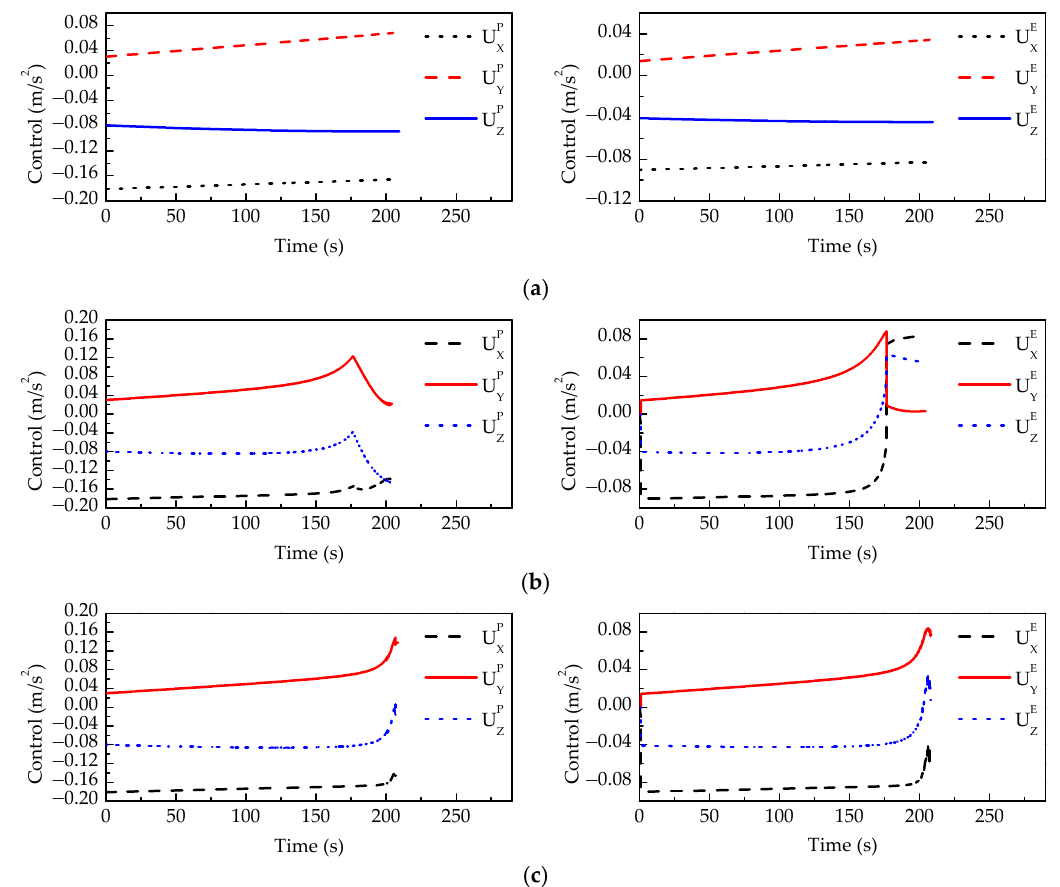
Figure 14. The average control variable of 100 Monte Carlo runs in the scenario that the evader plays ( a ) without time delay; ( b ) without compensation for time delay; and ( c ) with compensation for time delay.